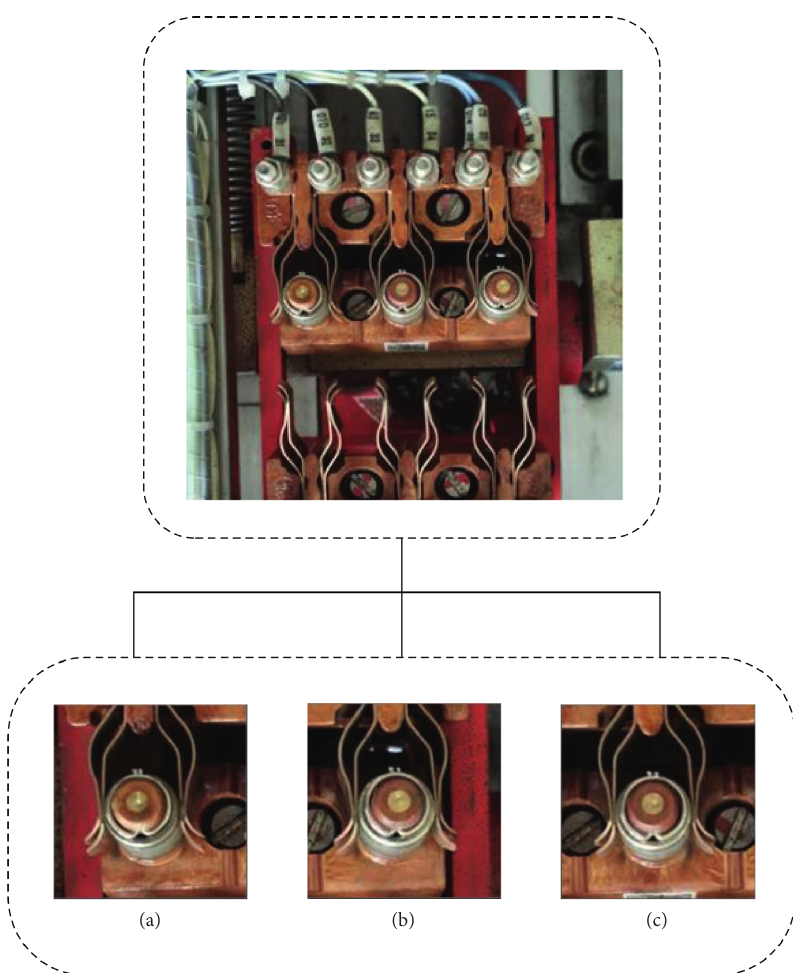
Figure 12: The subgraph segmentation: (a) the first moving contact; (b) the second moving contact; (c) the third moving contact.